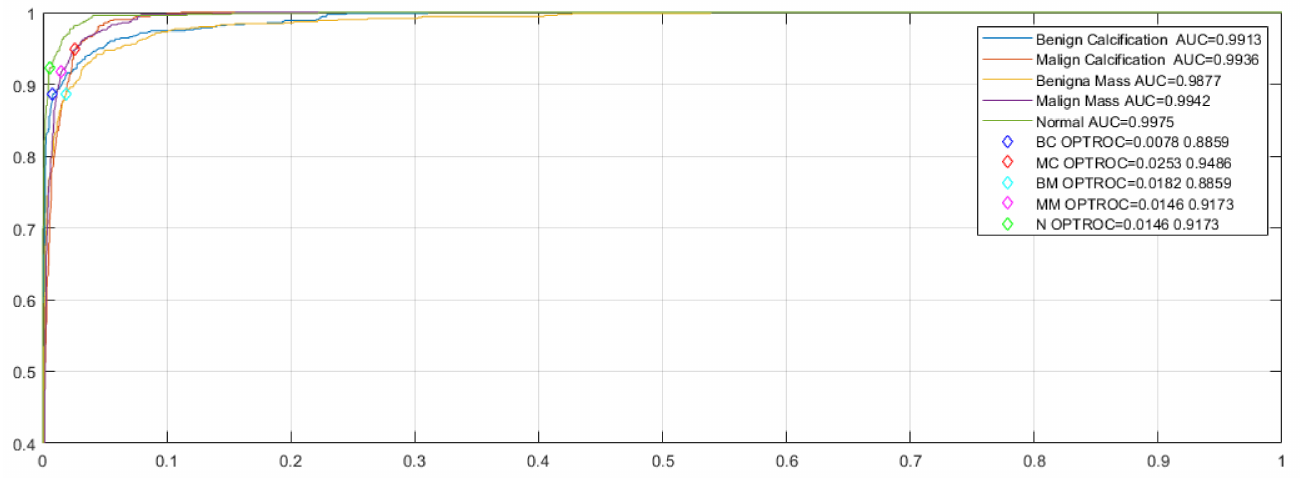
Figure 5. ROC and AUC of the GoogLeNet network trained with five categories and a balanced